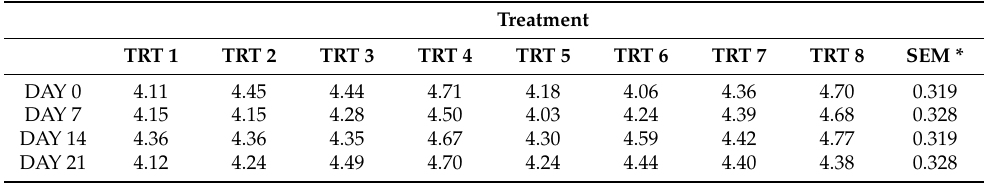
Initial beef color (1 = light purple red; 2 = slight purple red; 3 = moderately light purple red; 4 = red; 5 = slightly dark purple; 6 = moderately dark purple red; 7 = dark purple red; and 8 = extremely dark purple red). * SEM, standard error of the mean.